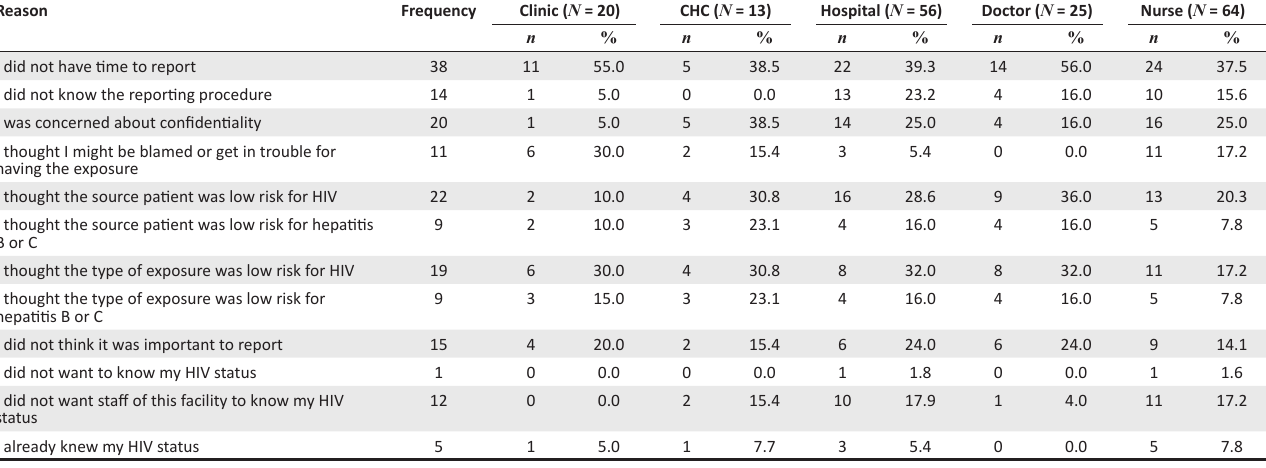
TABLE 5: Reasons for not reporting exposures across settings and